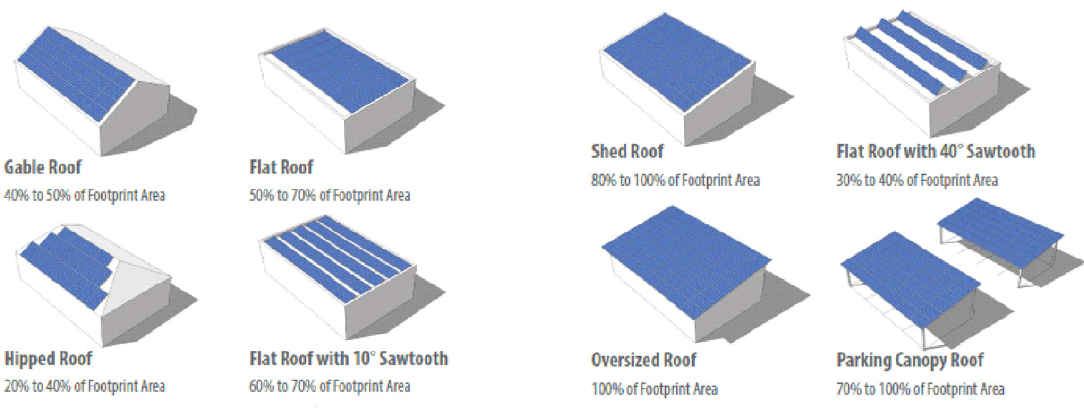
Figure 2. Placing photovoltaic panels on building roofs. Source: Adapted from Polly et al. [58]. Given the above data, we compute the energy generated by PV panels in three steps.